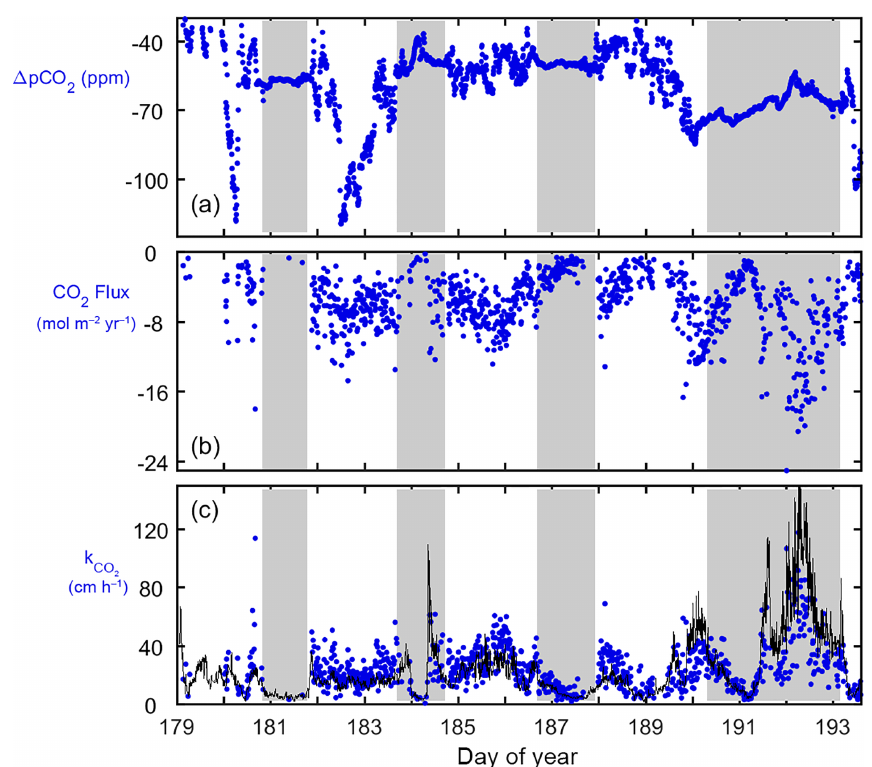
Figure 3. Knorr_11 cruise time series of 10min averaged CO 2 : (a) air–sea concentration difference ( (cid:49)p CO 2 ) , (b) flux ( F CO2 ) and (c) gas transfer velocity ( k CO2 ; water side only, no Sc correction). Panel (c) also shows k CO2 calculated using the NOAA COARE model (black line). Note that negative k CO2 data points in (c) were omitted for clarity (see Fig. S6 for full data set). Grey shaded regions represent periods on